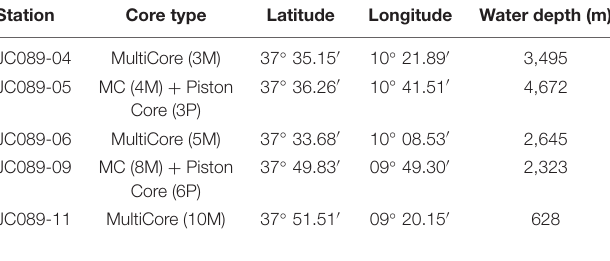
TABLE 1 | Sampling locations, method of coring and water depth.